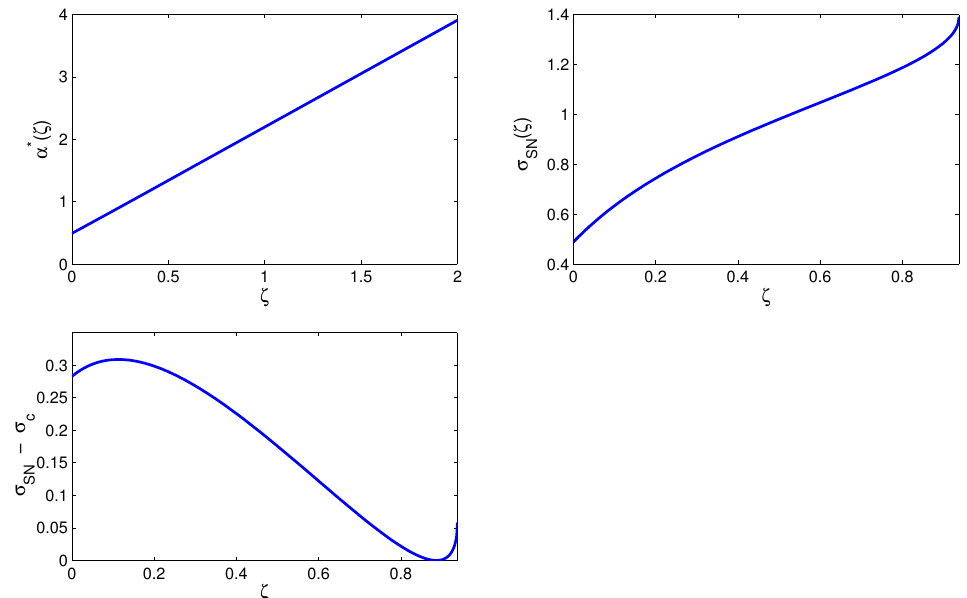
Figure 3. Thresholds (16) as function of the information variable ζ . The other parameters are chosen as in Figure 1. ( Top-left ) The threshold α ∗ ( ζ ) as function of ζ . ( Top-right ) The saddle-node bifurcation threshold σ SN ( ζ ) as function of ζ . The threshold σ SN is feasible in the range ( 0, ζ ∗ ] , with ζ ∗ = 0.9375 ( Bottom ) The length of the bistability range, i.e., σ SN − σ c , within the backward scenario as function of ζ . The bistability range is increasing for [ 0, ζ 1 ) and ( ζ 2 , ζ ∗ ) and it decreases for [ ζ 1 , ζ 2 ] . Here ζ ∗ = 0.9375; ζ 1 = 0.1135; ζ 2 =